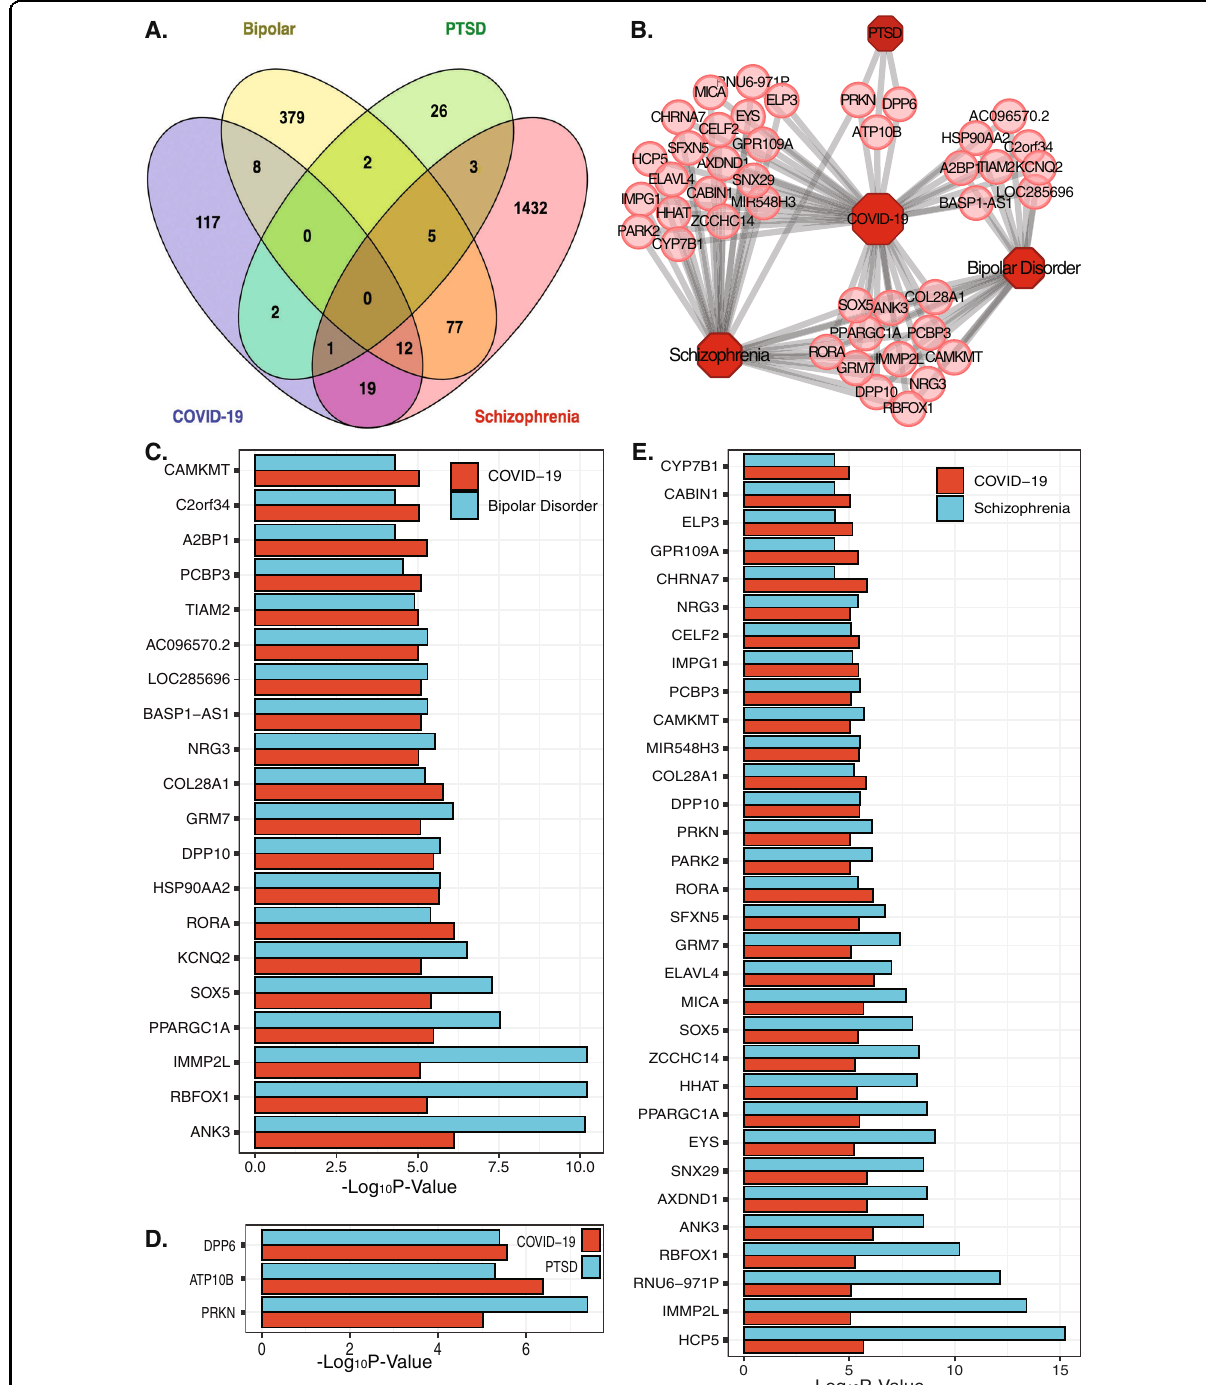
Fig. 4 GWAS of SARS-CoV-2 infected patients reveal shared common signi fi cant genes with the bipolar disorder, PTSD and schizophrenia in GWAS and WGS datasets. A Venn diagram shows the number of common signi fi cant genes of SARS Cov-2 with the bipolar disorder, PTSD and schizophrenia genes. B Barchart shows the signi fi cant shared genes of SARS-CoV-2 and schizophrenia, and their corresponding 10 based − log p -values. C Barchart shows the signi fi cant shared genes of SARS-CoV-2 and bipolar disorder, and their corresponding 10 based − log p -values. D Barchart shows the signi fi cant shared genes of SARS-CoV-2 and PTSD, and their corresponding 10 based − log p -values. E Association network of the common signi fi cant genes identi fi ed in SARS-CoV-2 infected patients with the bipolar disorder, PTSD and schizophrenia in GWAS and